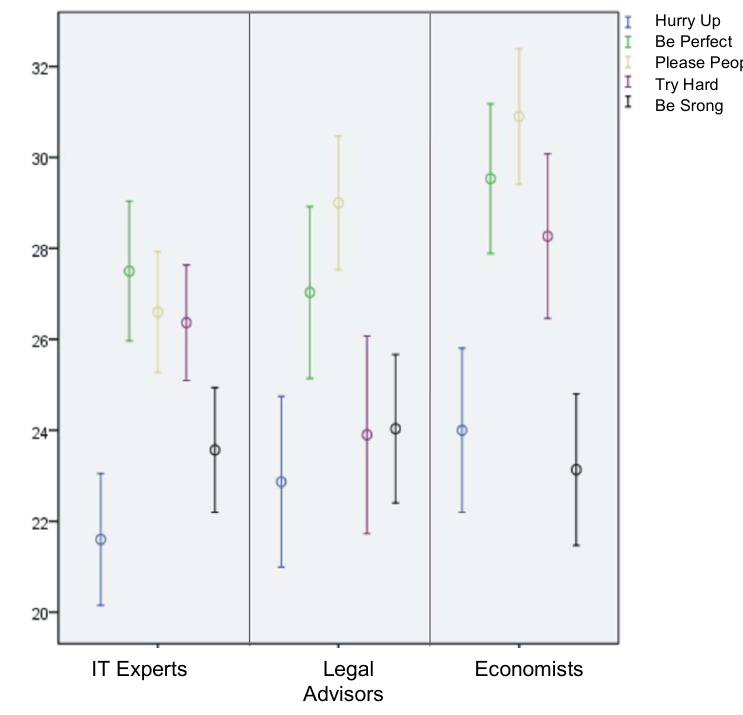
Figure 4. Confidence interval error bars